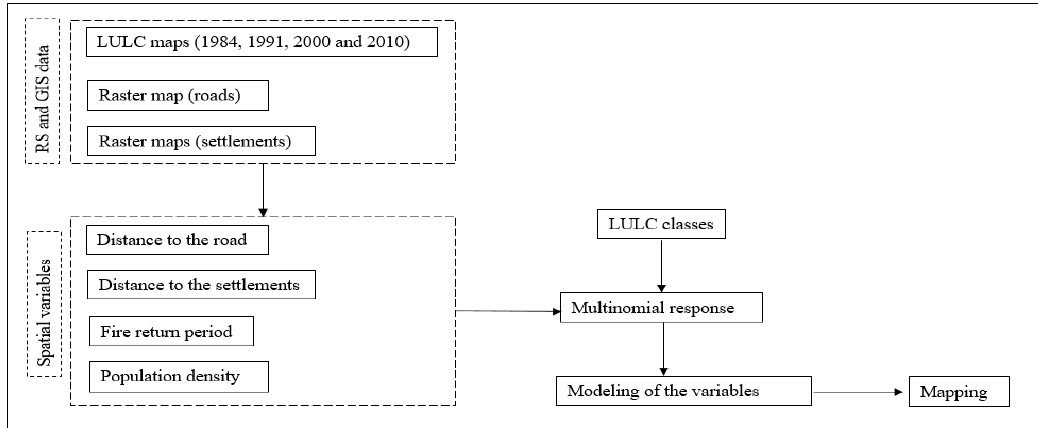
Figure 3. Steps used for the development of the probability maps for the occurrence of selected land use and land cover (LULC) change conversions in the protected and communal area.